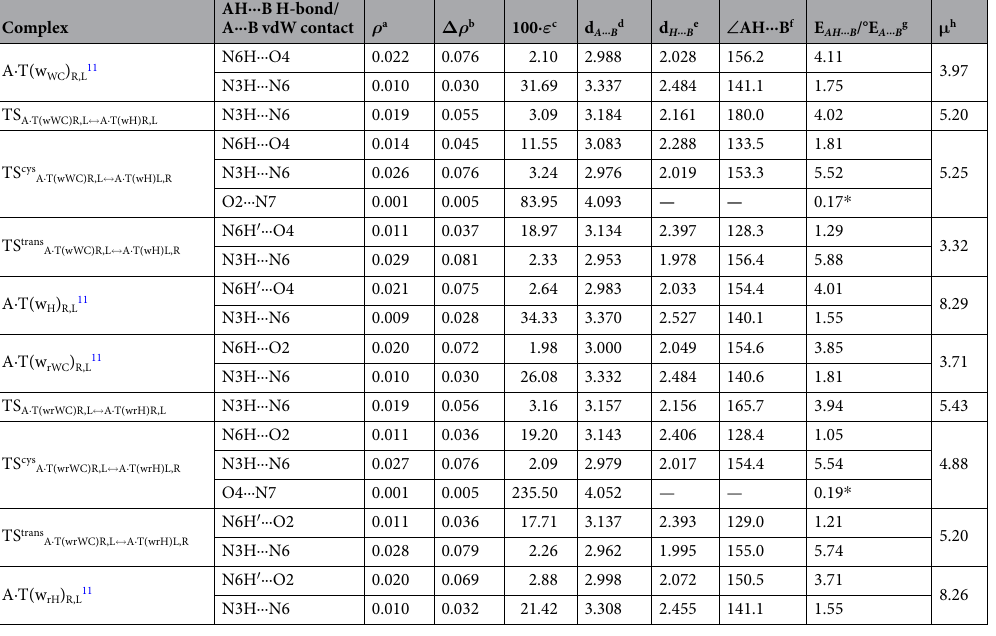
Table 2. Electron-topological, geometrical and energetic characteristics of the intermolecular specific contacts in the investigated conformers of the А·Т DNA bps and TSs of their conformational transformations obtained at the B3LYP/6-311 ++ G(d,p) level of theory ( ε = 4) (see Fig. 1). a The electron density at the (3, − 1) BCP of the specific contact, a.u. b The Laplacian of the electron density at the (3, − 1) BCP of the specific contact, a.u. c The ellipticity at the (3, − 1) BCP of the specific contact. d The distance between the A and B atoms of the specific contact, Å. e The distance between the H and B atoms of the AH···B H-bond, Å. f The H-bond angle, degree. g Energy of the AH···B H-bond or attractive A···B van der Waals (vdW) contact, calculated by Iogansen’s or Espinose-Molins-Lecomte (marked with an asterisk) formulas, kcal∙mol − 1 . The dipole moment of the complex,